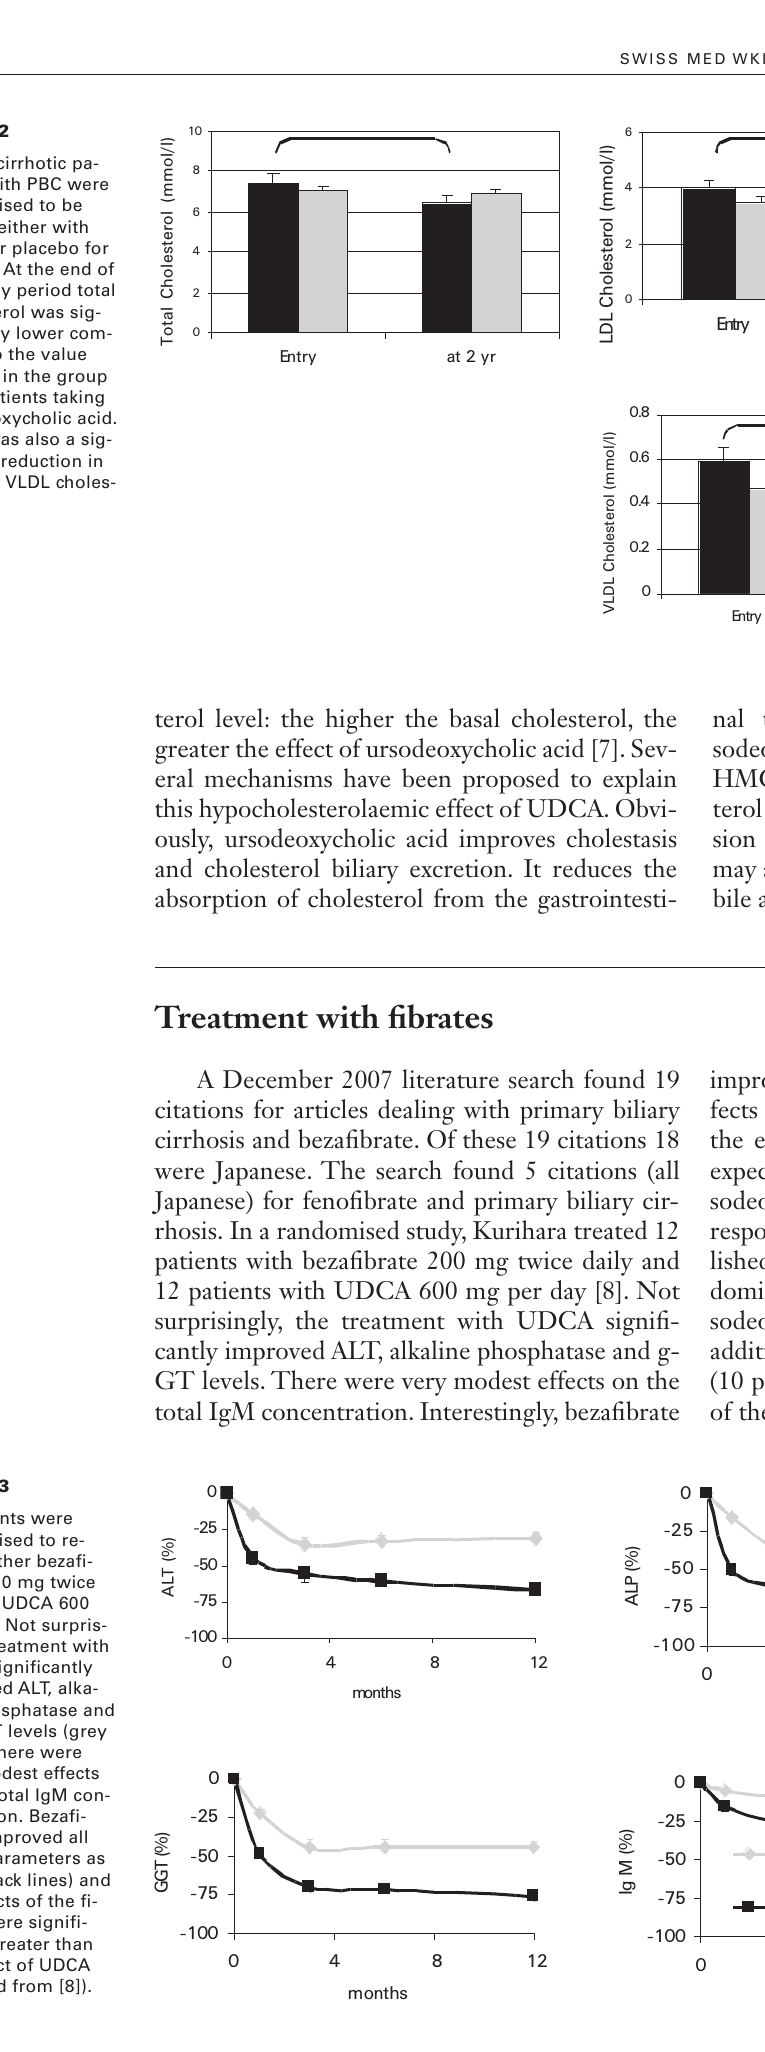
33 non-cirrhotic pa- tients with PBC were randomised to be treated either with UDCA or placebo for 2 years. At the end of the study period total cholesterol was sig- nificantly lower com- pared to the value at entry in the group of 17 patients taking ursodeoxycholic acid. There was also a sig- nificant reduction in LDL and VLDL choles- terol.